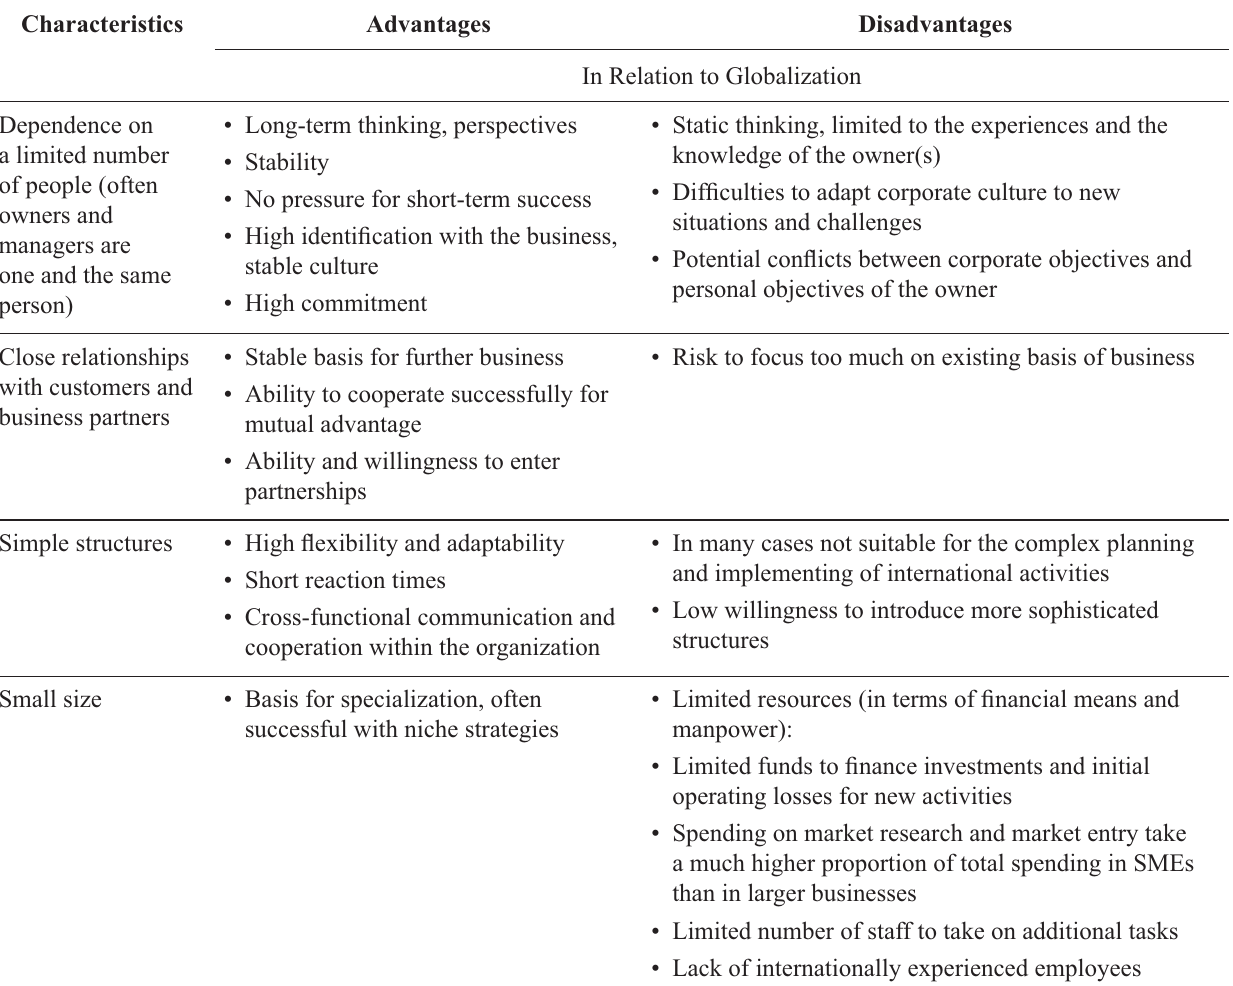
Table 1. Small business in relation to